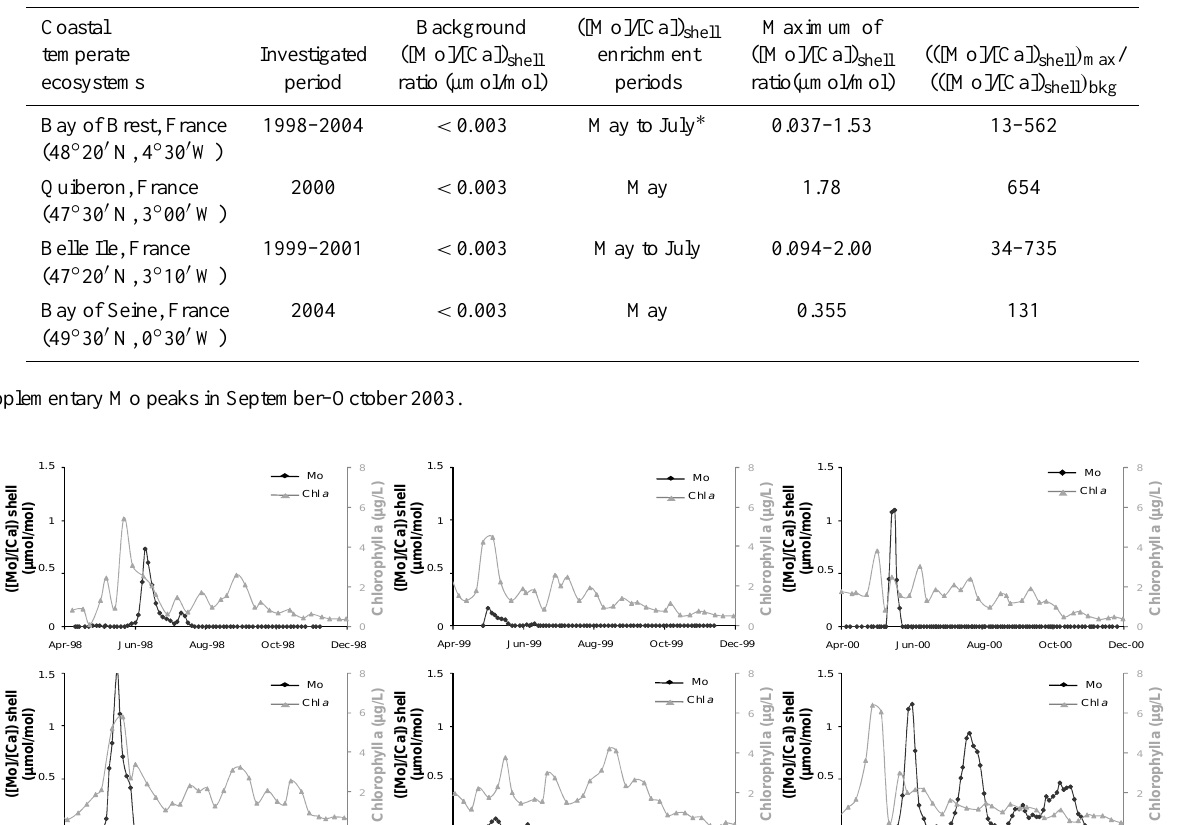
Table 2. ([Mo]/[Ca]) shell ratio history in bivalve shells from different coastal temperate ecosystems. Both background, maximum